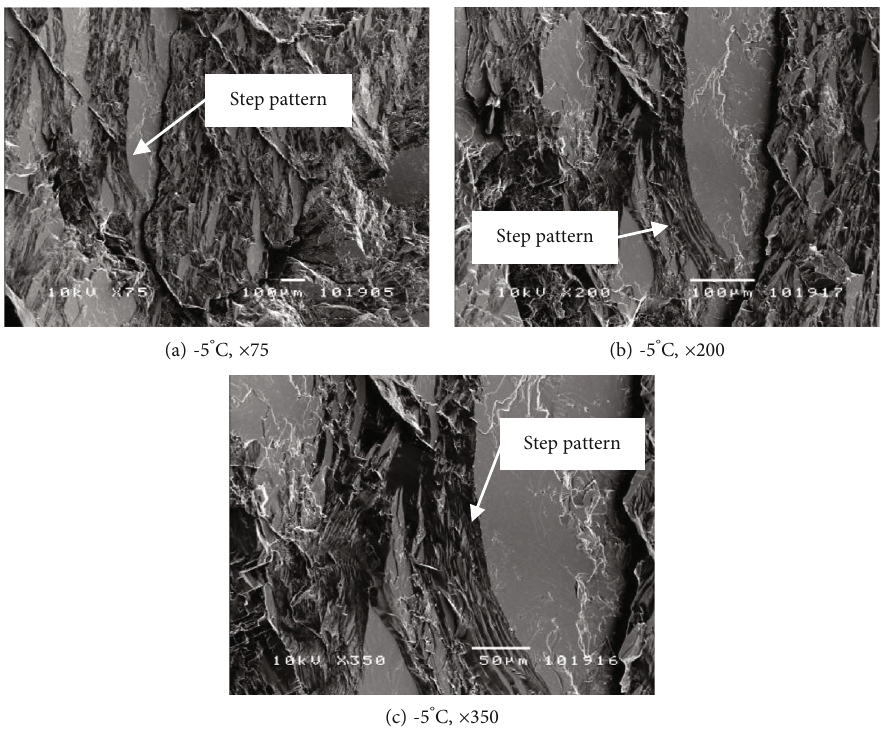
Figure 9: A series of steps on a cleavage plane of